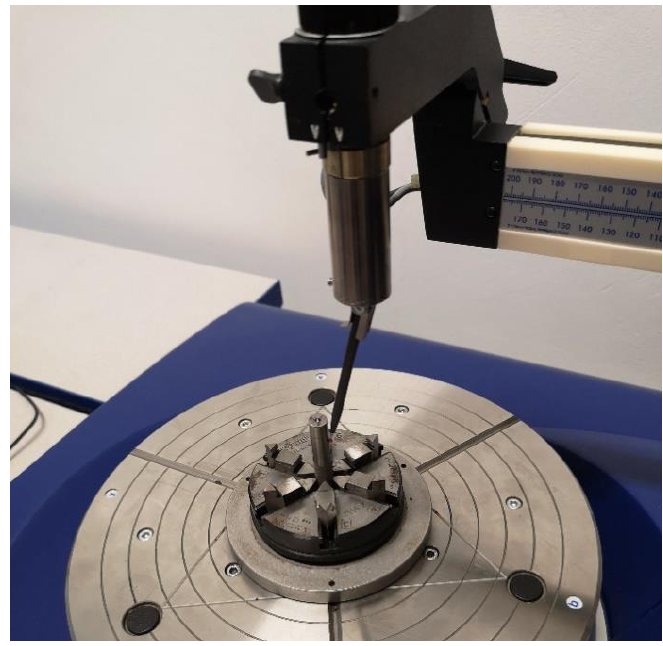
Figure 4. Measuring area of the Taylor Hobson Talyrond 365 circular shape and positional error measuring equipment.